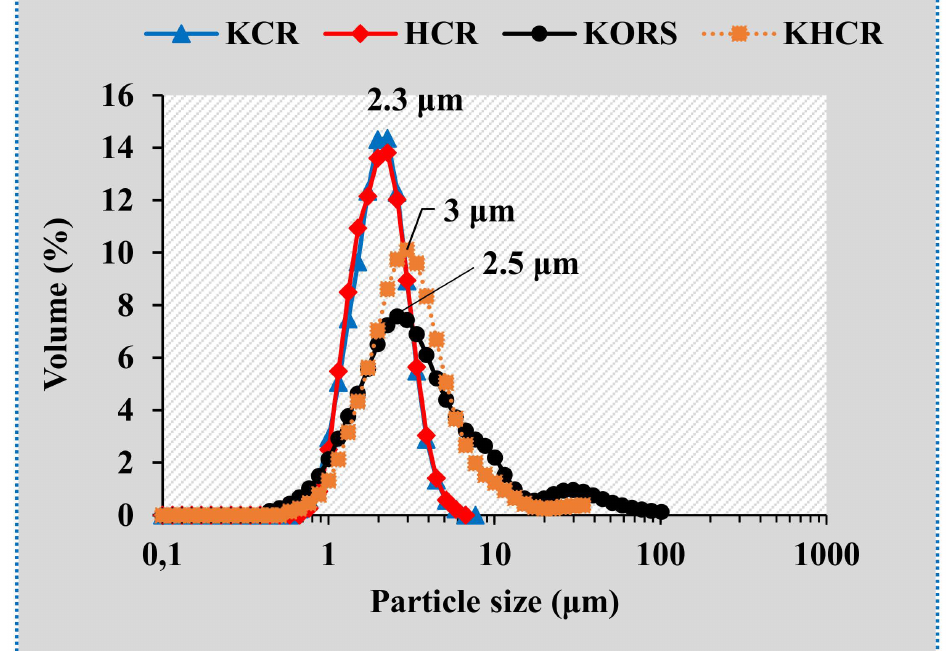
Figure 5. Particle size distribution of the clay-based suspensions prepared for freeze-tape casting (obtained after milling and sieving).